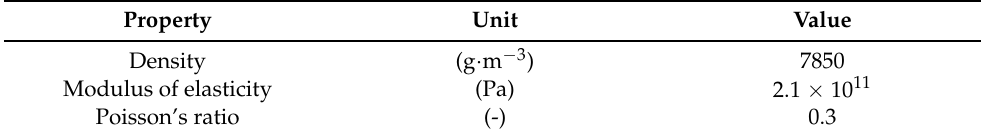
Figure 9. The CAD model of the investigated structures. Table 4. Material properties of the